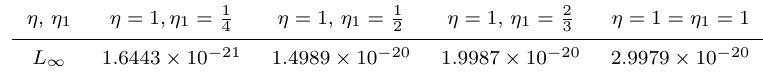
Table 4. The comparison of the L ∞ error obtained by our numerical method with m = m ′ = 1 and M = M ′ = 64 for different values for η 1 and η for Example 2. η, η 1 η = 1 ,η 1 = 1 4 L